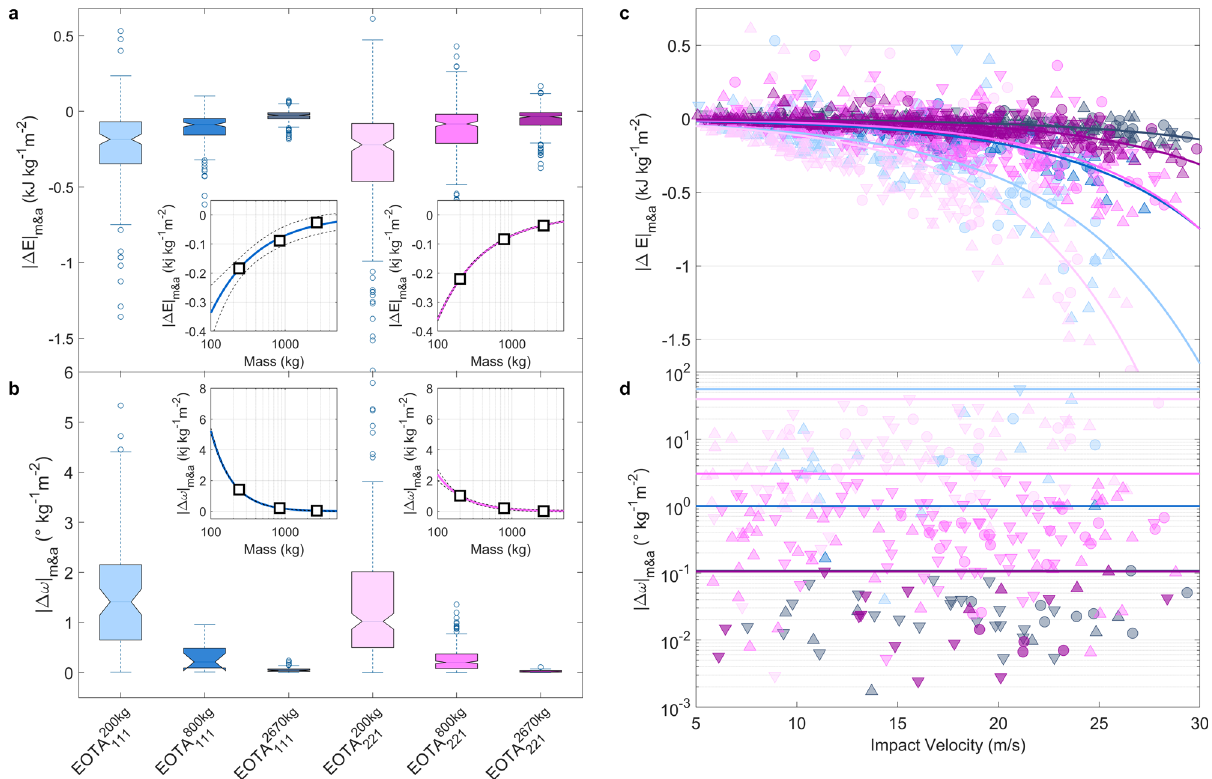
Fig. 5 Mass and impact cross-section normalised energy dissipation and angular velocity changes for all analysed impacts. a The stiletto effect in rockfall — mass and impact cross-section normalised energy dissipation boxplot for the three larger weight classes. Insets present empirical power laws for both shape categories with its 1 σ -prediction bounds. b Impact-induced changes in absolute angular velocity scaling with mass and surface area. Insets present empirical power laws for both shape categories with its 1 σ -prediction bounds. Both boxplots feature median values with standard whisker coverage of 99.3 % (2.7 σ ). c Velocity dependence of weight and impact cross-section normalised energy dissipation of 1394 analysed impacts for the three larger weight classes. The smaller the rock cross-section the more pronounced the effect — equivalently to a person running in stiletto high heels as opposed to sneakers. The lines represent exponential fi ts to the different weight and shape classes in the general colour code and serve as a guide to the eye. Upward facing triangles mark impacts in the acceleration zone, circles in the transition zones, and downward facing triangles in the runout zones. d Angular velocity changes upon 656 analysed impacts across the different weight and shape classes impact areas. Horizontal lines mark the maximal change in angular velocity per weight class. Equivalent color code as in Fig. 2